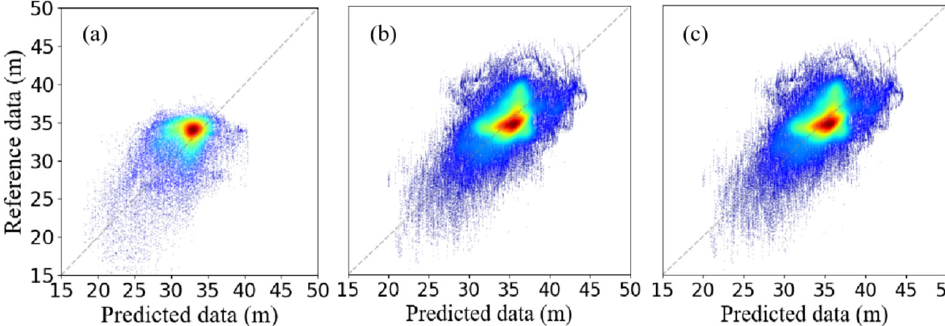
Figure 14. Scatter density plots of predicted water depths in areas ( a ) A2, ( b ) A3, and ( c ) A4.